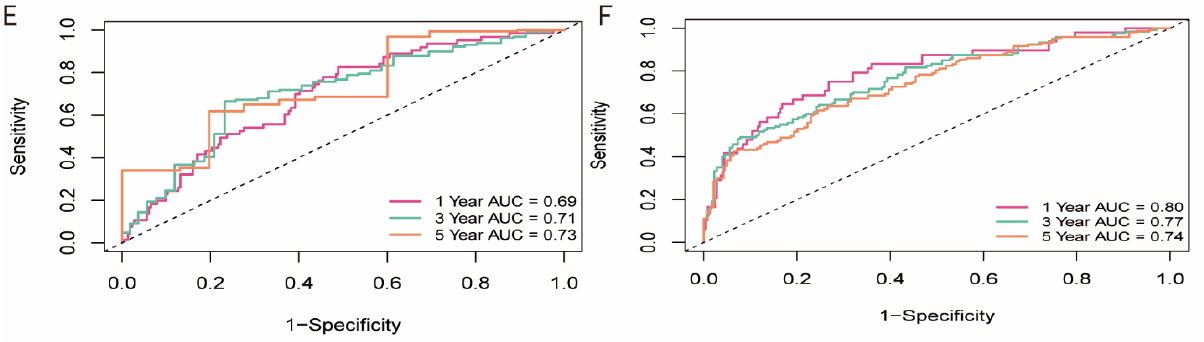
Figure 6. Conducting nomograms. ( A , B ) RiskScore and age were associated with the prognosis of patients with GC, and nomograms were conducted. * 0.05; ** 0.01; *** 0.001. ( C , D ) Nomogram-predicted OS at 1, 3, and 5 years were conducted. ( E , F ) The AUC at 1, 3, and 5 years were calculated.